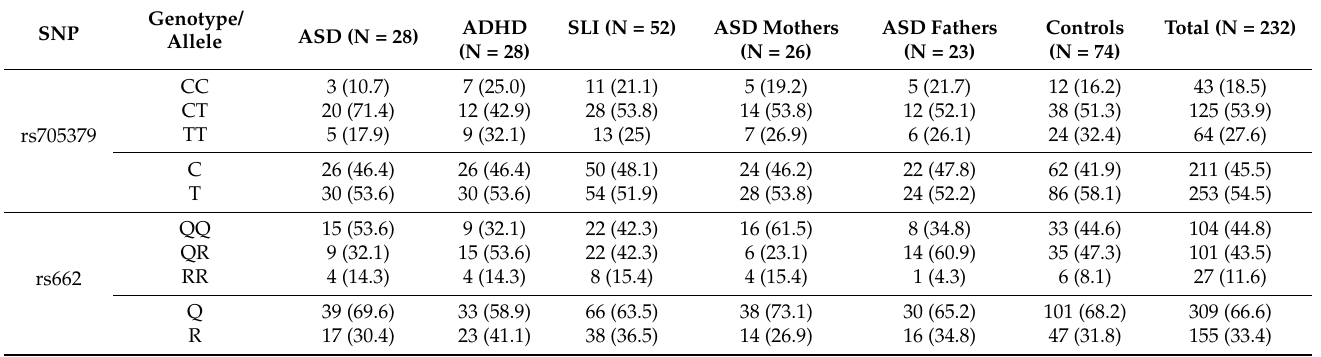
Table 2. Allele and genotype distribution of SNPs rs705379 (C-108T) and rs662 (Q192R) in the different samples analyzed. Data are presented as N (%).